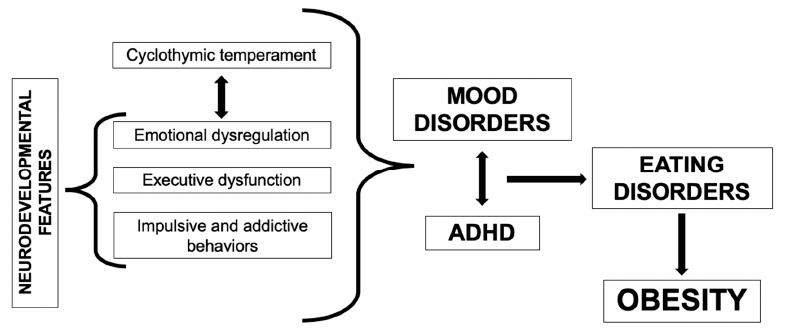
Figure 2. Obesity-related neuropsychiatric syndromes display a substantial overlap or homology, suggesting the existence of a common psychopathologic ground for the emergence of maladaptive eating behaviors, which can lead to obesity in the long run.